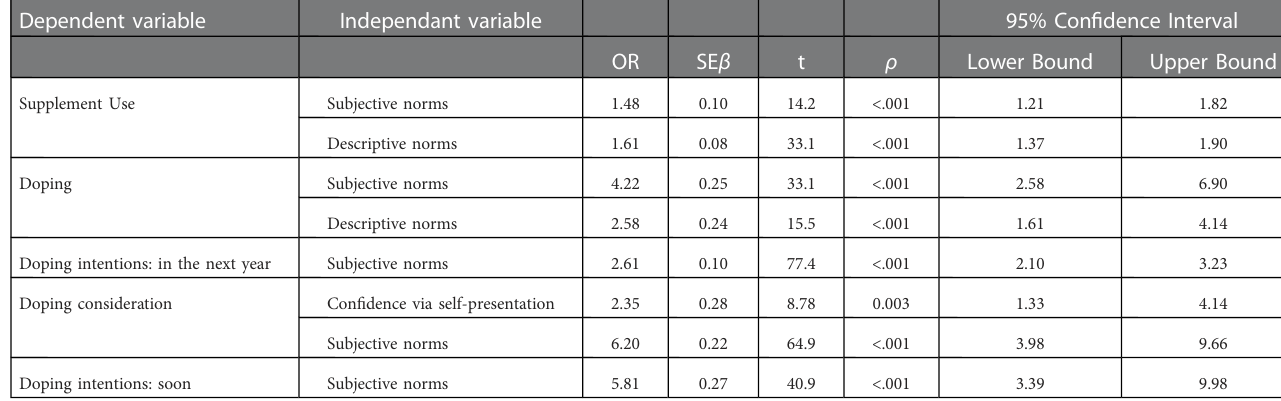
TABLE 2 Summary of models that increase the odds of supplement use, doping, doping intentions and doping consideration among adolescent athletes. Dependent variable